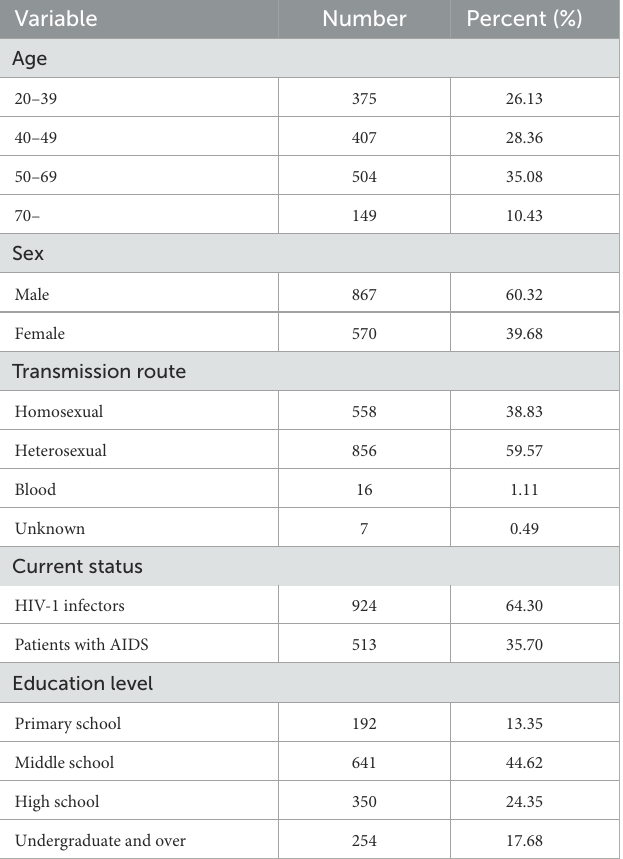
TABLE 1 The basic characteristics of population with HIV-1 living in Fuyang,